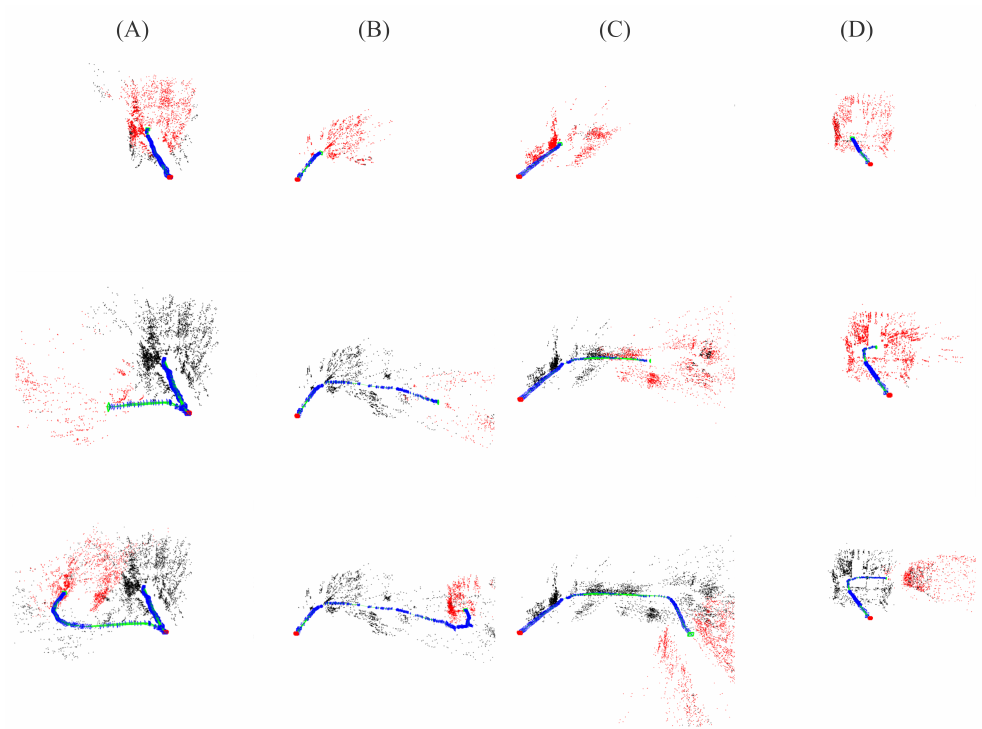
Figure 8. Example of the 3D point cloud of ( A ) the U-shaped hallway; ( B ) the H-shaped hallway; ( C ) the Loop-shaped hallway; ( D ) the T-shaped